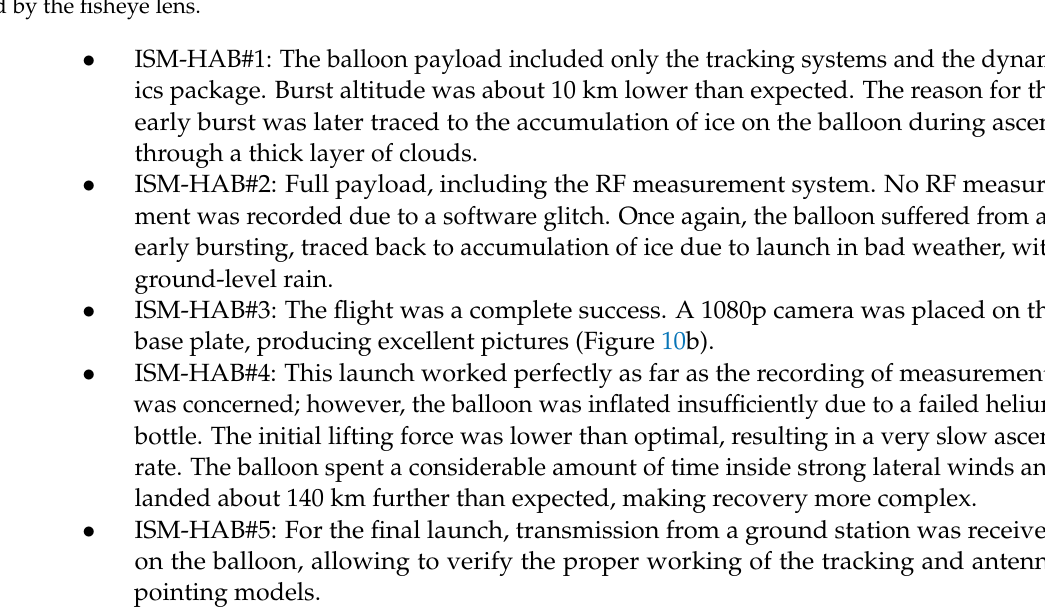
Figure 10. ( a ) Trajectories of the five missions. ( b ) Picture taken during ISM-HAB #3 at 30 km altitude. The curvature of the Earth is accentuated by the fisheye